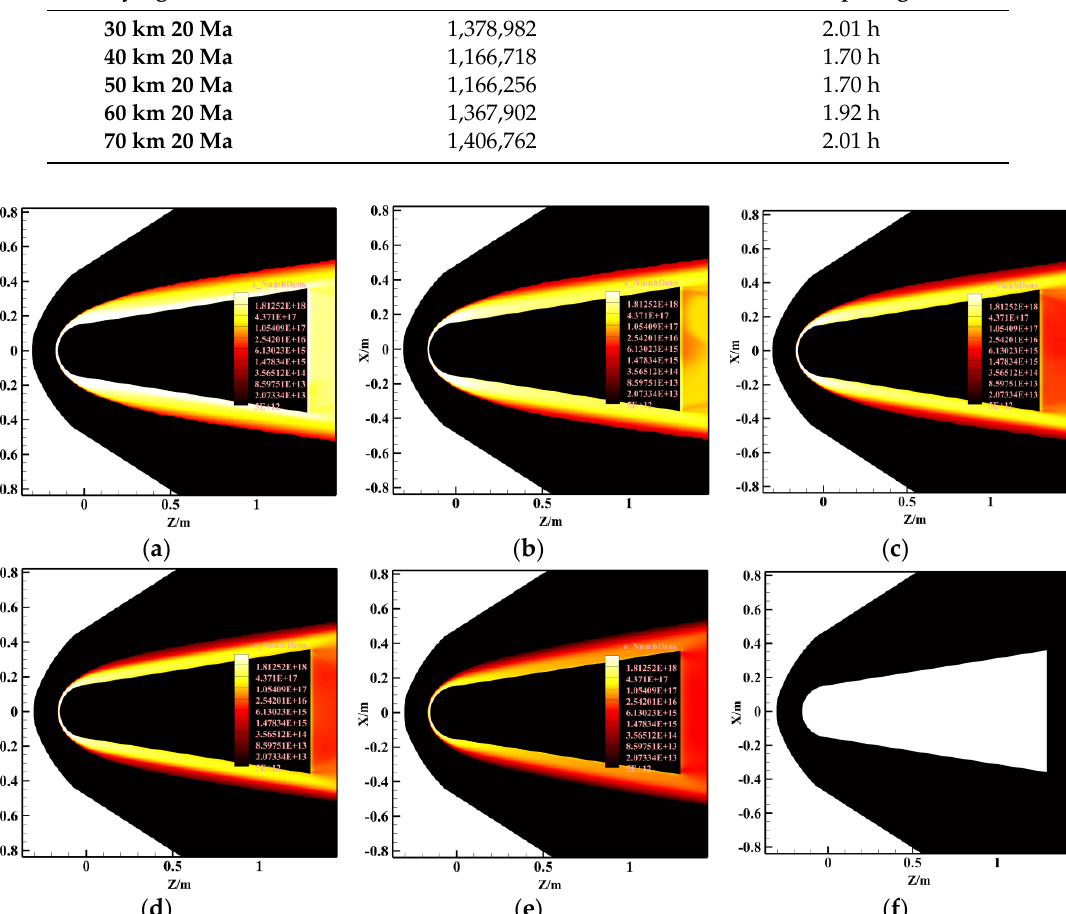
Figure 3. Electron density distribution field of the plasma sheath at: ( a ) 30 km, 20 Ma; ( b ) 40 km, 20 Ma; ( c ) 50 km, 20 Ma; ( d ) 60 km, 20 Ma; ( e ) 70 km, 20 Ma; and ( f ) 0 km, 0